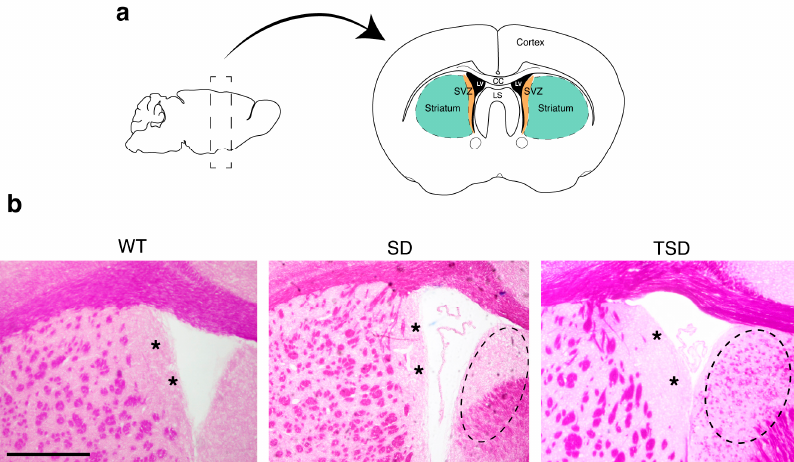
Figure 1. SVZ and STR tissues isolated from WT, TSD and SD mice. ( a ) Schematic of brain dissection: with two cuts we isolate a slice of tissue comprising the lateral ventricles. The periventricular area (SVZ; orange) and a portion of striatum (STR; green) are carefully dissected out from both hemispheres using small forceps. Black, lateral ventricles (LV); white, corpus callosum (cc); lateral septal (LS). ( b ) Representative images of PAS staining on vibratome-cut brain coronal sections from SD, TSD and WT mice. The asterisks indicate the SVZ region. The dotted ellipse indicates representative pathological changes Scale bar: 300µm.